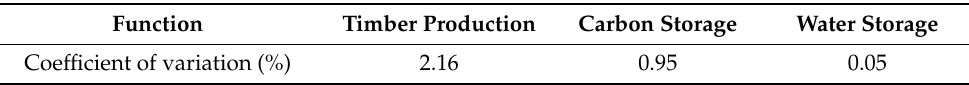
Table 7. Coefficient of variation (CV) of the total NPVs of timber production, carbon storage, and water storage by alternatives.